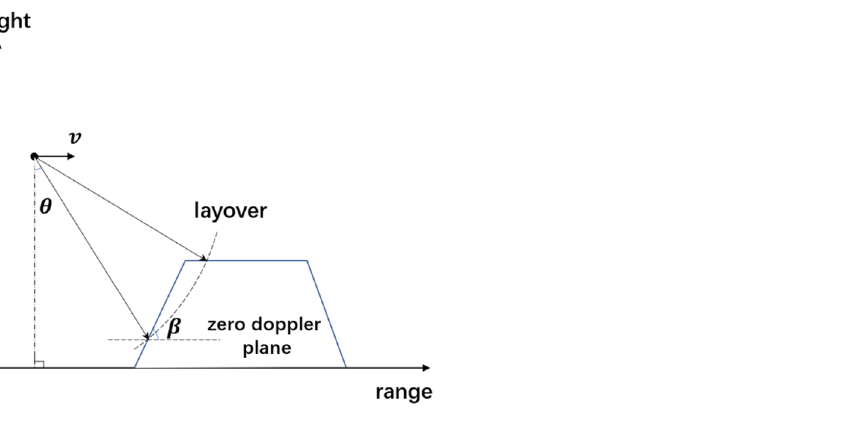
Figure 2. The geometry model of the layover. ν is the radar motion direction. Layover appears when the viewing angle θ is smaller than the slope angle β .